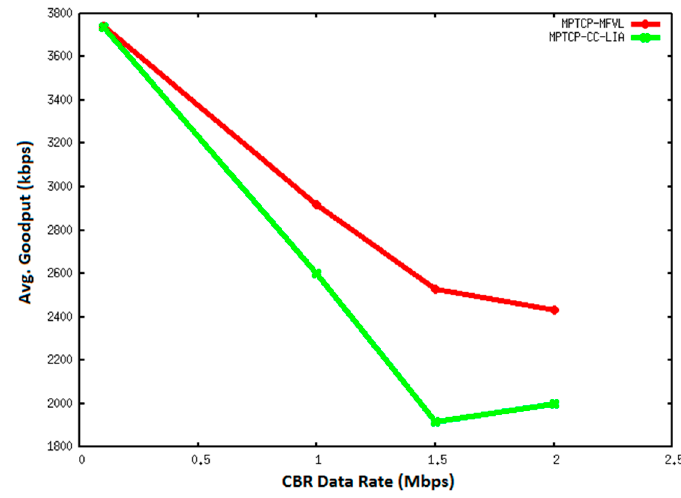
Figure 19. Average goodput result with CBR data rate 0.1 to 2 Mbps.